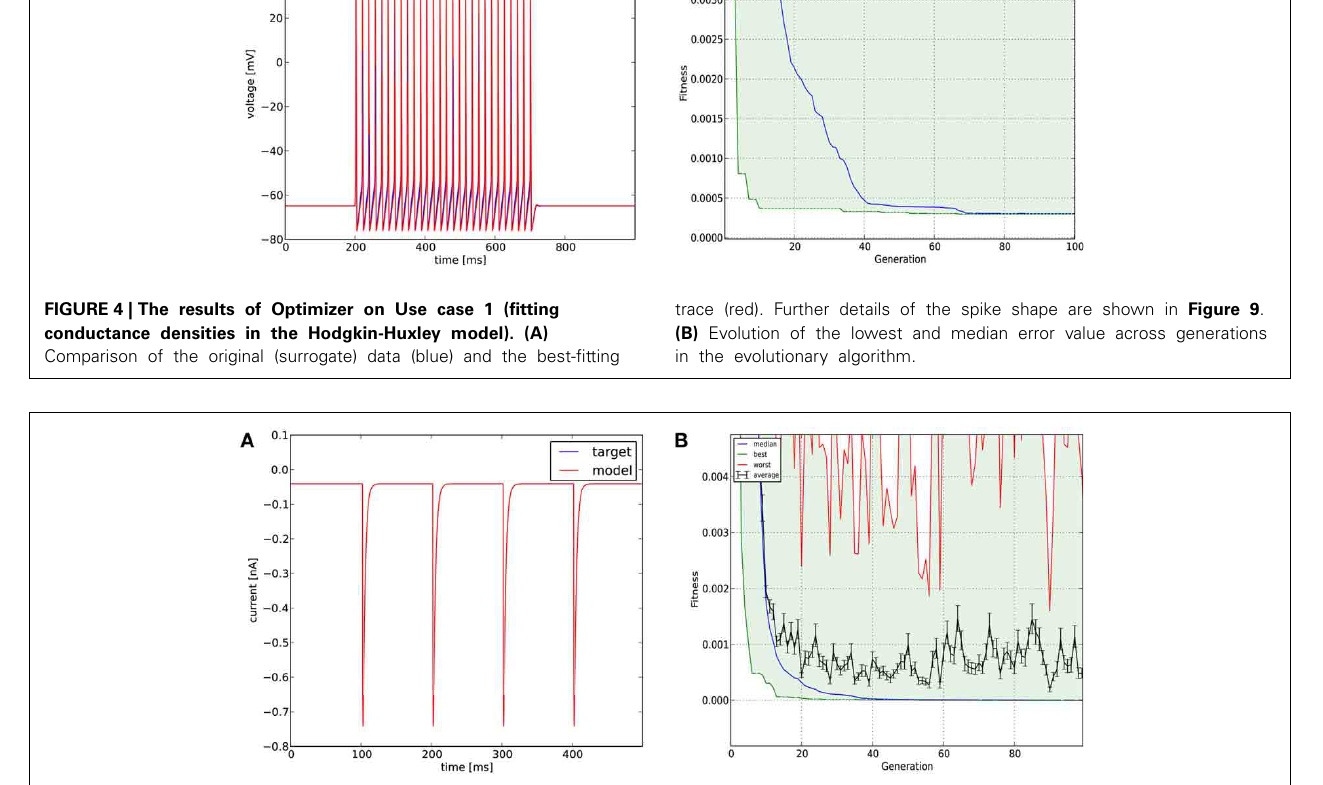
FIGURE 5 | The results of Optimizer on Use case 2 (fitting synaptic parameters in voltage clamp). Figure layout and notation are similar to Figure 4 ; the error plot in (B) also shows the average and worst fitness values for each